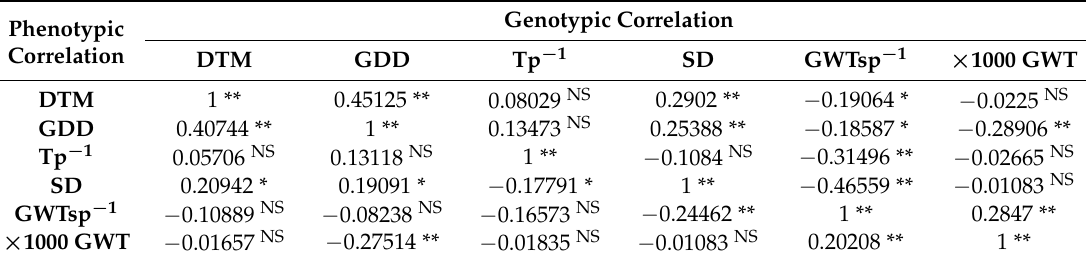
Table 6. Genotypic and Phenotypic